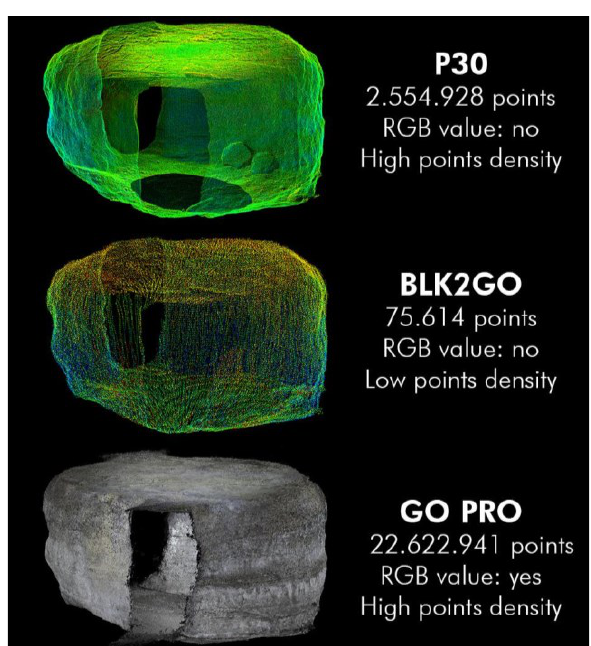
Figure 9 . Room 23: variation of the points cloud density.